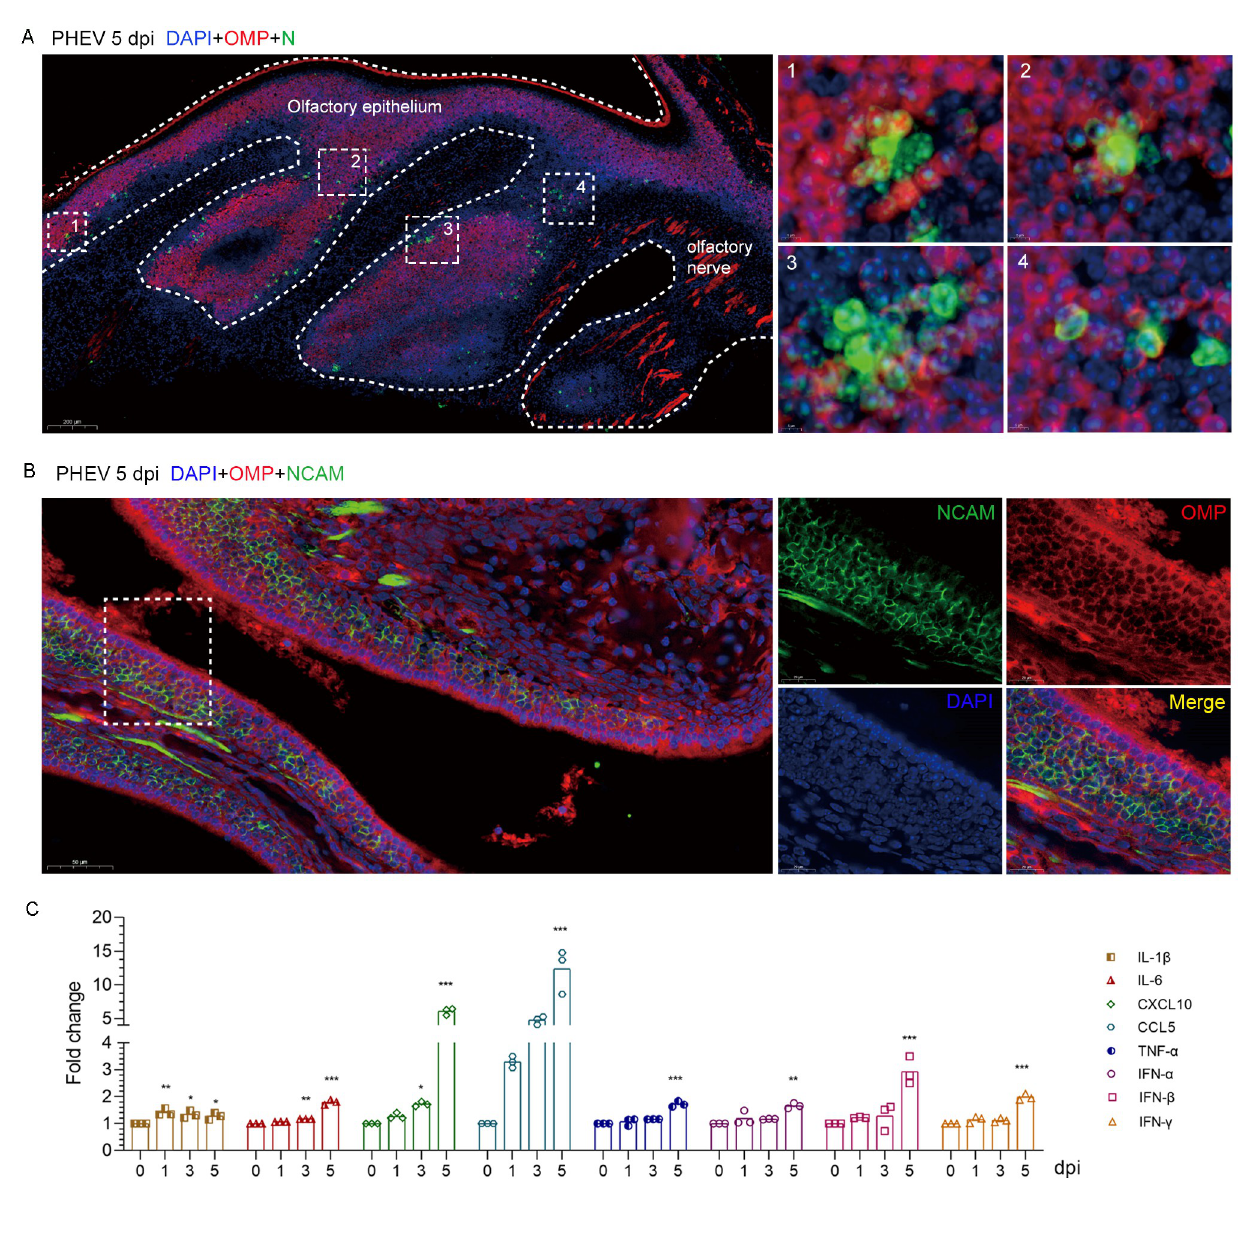
Fig 10. Cell target and inflammatory responses in the OE of PHEV-infected mice. The 3w BALB/c mice were intranasally inoculated with 10 3.96 TCID 50 PHEV, and nose samples were collected at indicated times. (A) Immunofluorescence staining of PHEV-N (green) and olfactory neuron marker OMP (red) in OE at 5 dpi. Magnified images (panels 1–4 ) show the colocalization of N with OMP-expressing OSNs. ( B ) Immunofluorescence staining of NCAM (green) and olfactory neuron marker OMP (red) in the mice OE at 5 dpi. NCAM, neural cell adhesion molecule. (C) Expression of IL-1 β , IL-6, CXCL10, CCL5, TNF- α , IFN- α , IFN- β , and IFN- γ mRNA in homogenized nasal turbinate tissues was determined by qRT–PCR. Three mice per time point were analyzed. Data are normalized to GAPDH and presented as fold changes in expression relative to mock (0 dpi) and shown as the means ± SD. P values were determined by one- way